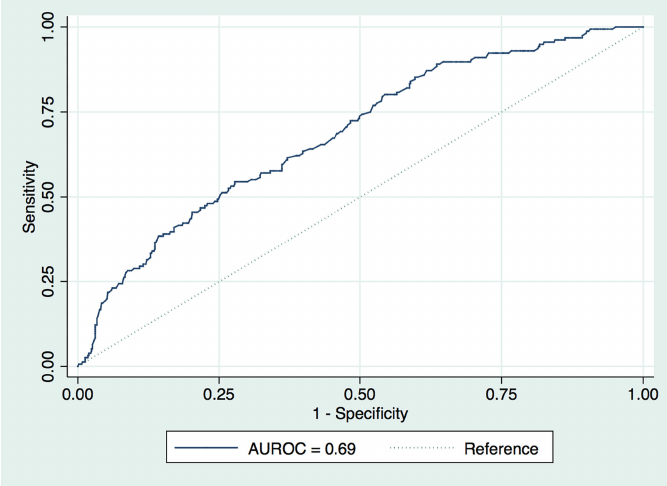
Figure 3 - Prediction of upgrade on systematic biopsy, ROC curve. The area under the ROC curve of the model was 0.69, only marginally discriminating between men in whom systematic biopsy will and will not lead to upgrade to clinically signifi cant prostate